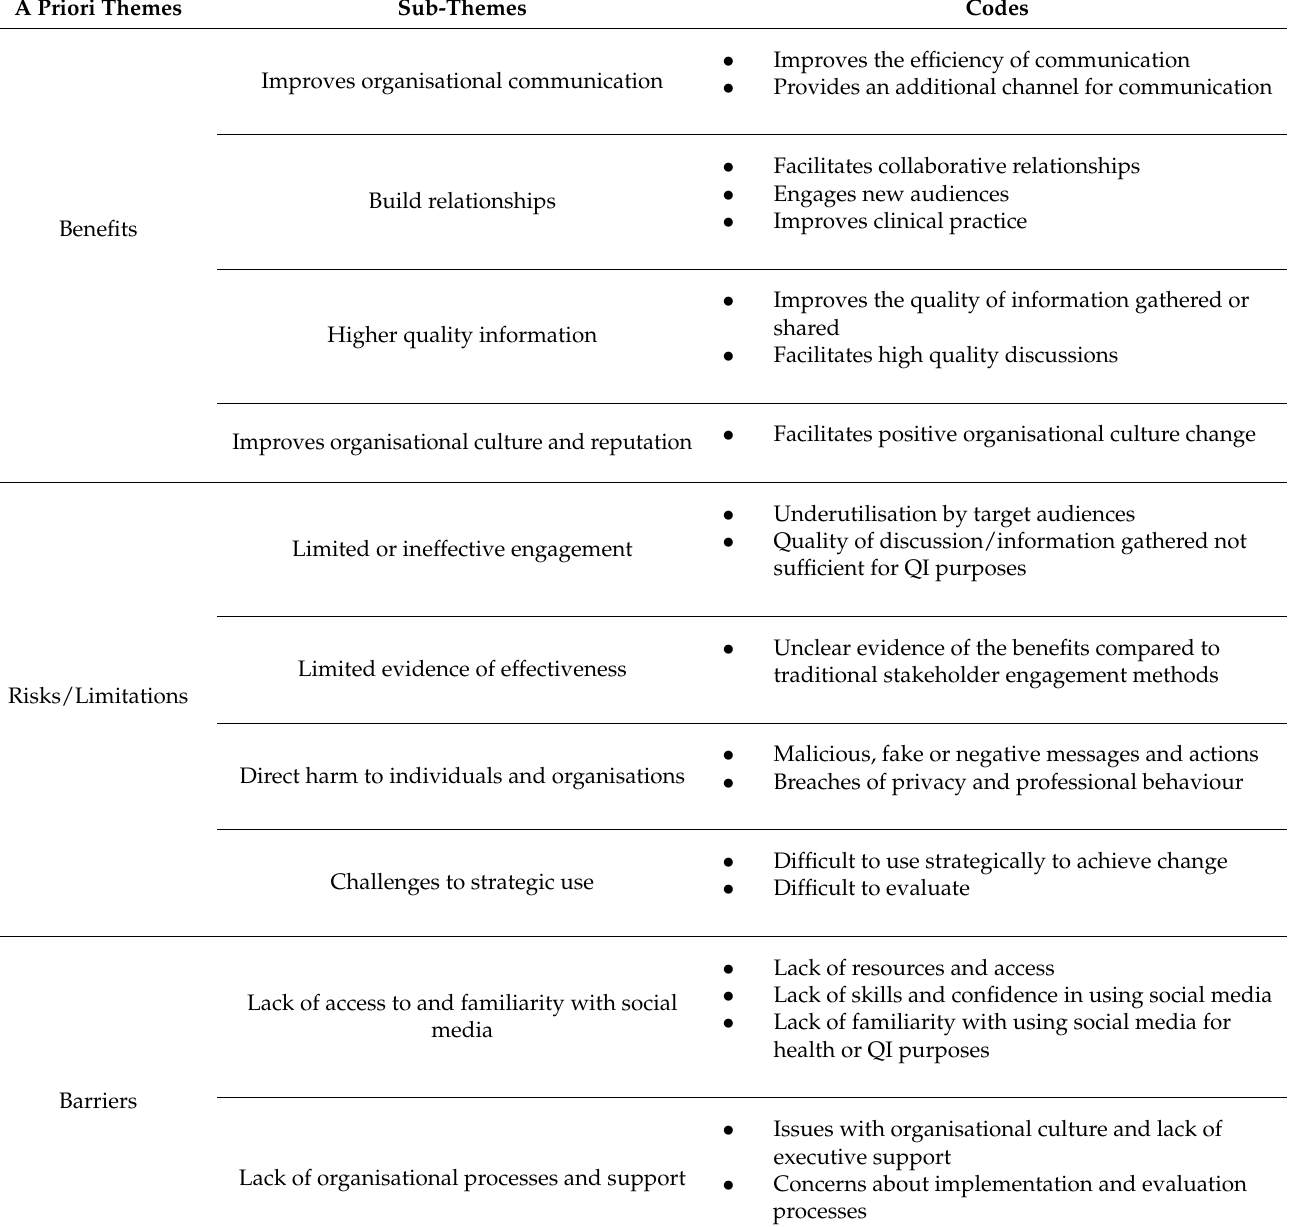
Table 3. Experience of social media use—themes, subthemes and